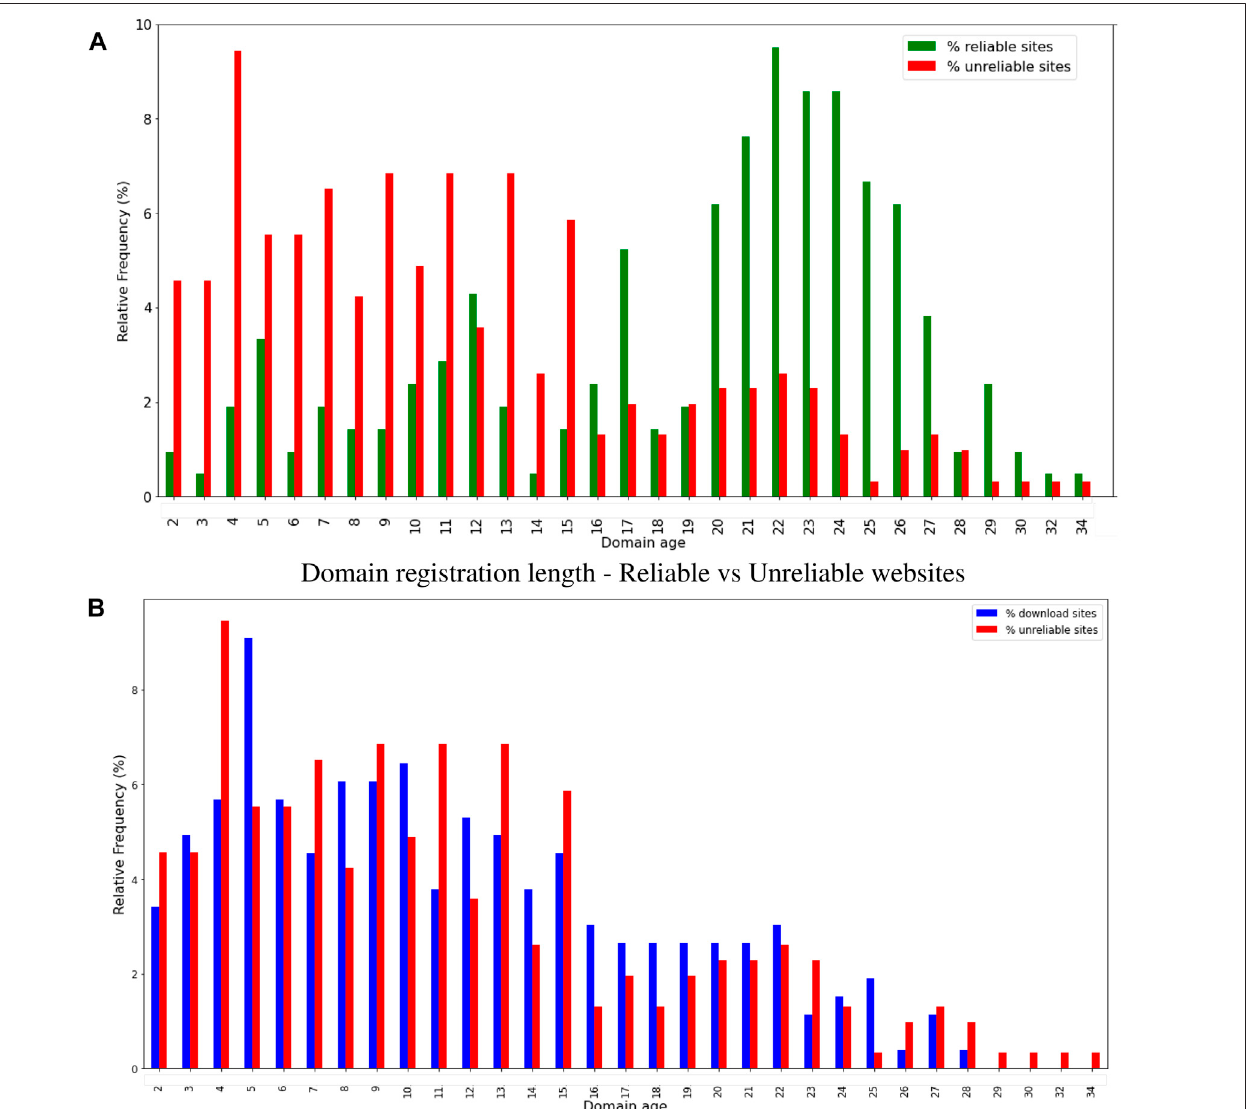
FIGURE9| Domainregistrationlength(registration/renewalperiod).Theplot (A) displays thedomain registration length, meantasthenumberofyearsthedomain renewal cost ispaid inadvance, calculated in thereliable and unreliable datasets. Webmaster says SearchEnginegives more preference tothe domains registered fora long time becausedomains thatare boughtforthespammingWebaregenerallyregistered fornotmore than ayear. Newly registered domains areoften favored bybad actors for malicious purposes (including phishing, malware installation, scam, or fake news spread) and are generally registered for not more than 5 years. An example is provided by illegal piracy websites (B) such as torrent or streaming websites or also direct download platforms. Many websites go of fl ine after a while or are shut down due to copyright violations and illegal fi le-sharing; therefore, owners of such domains usually do not register a domain for longer than a couple of years.